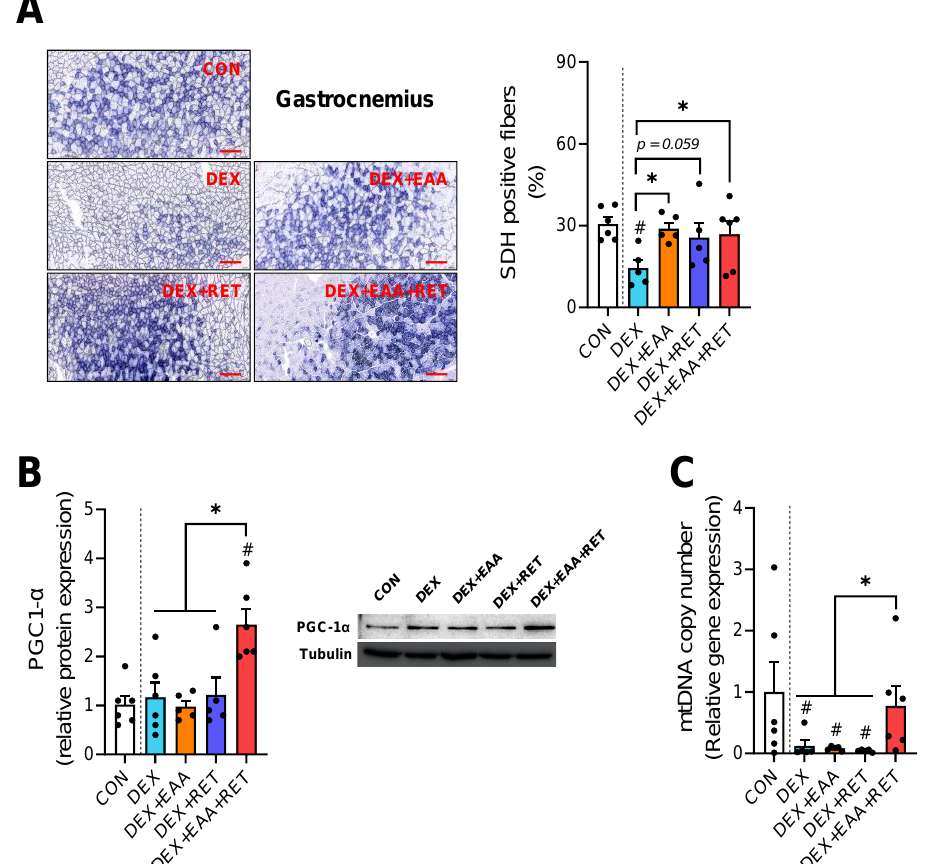
Figure 5. Combined treatment of EAA and RET completely restores the loss of mitochondrial biogenesis in skeletal muscle by DEX treatment. ( A ) Representative image and the proportion of SDH-positive muscle fibers in gastrocnemius (n = 5–6). Scale bar, 200 µ m. ( B ) Representative image and relative protein expression of the PGC1- α in gastrocnemius (n = 5–6). ( C ) The relative mtDNA copy number with qPCR measurement in gastrocnemius (n = 5–6). Data are presented as mean ± S.E. # Significant difference from control group ( p < 0.05). * Significant difference between labeled groups ( p < 0.05). CON, sedentary control; DEX, dexamethasone; EAA, essential amino acids; RET, resistance exercise training; SDH, succinate dehydrogenase; PGC1- α , peroxisome proliferator-activated receptor gamma coactivator 1-alpha; mtDNA, mitochondrial DNA.